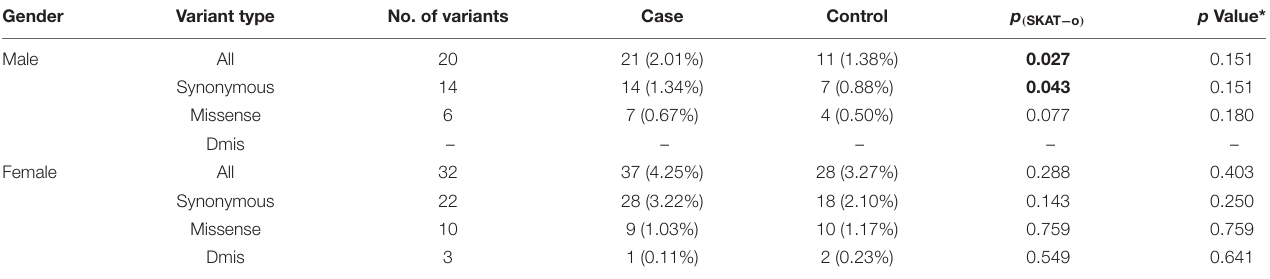
TABLE 3 | Gene-based association of TAF1 coding